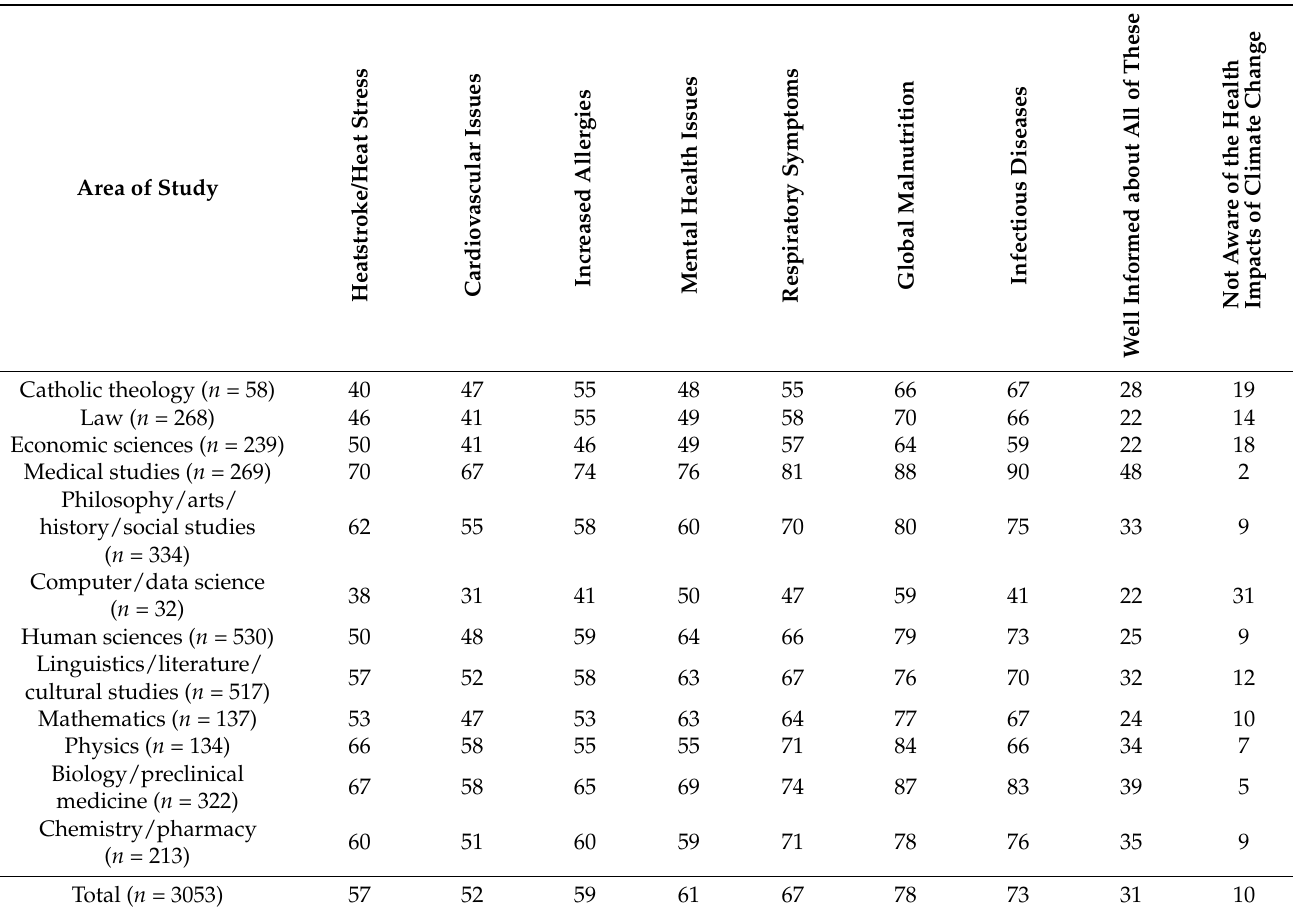
Table 2. Informedness by department: What health consequences of climate change have you already heard about? (proportion of affirmative answers; n =